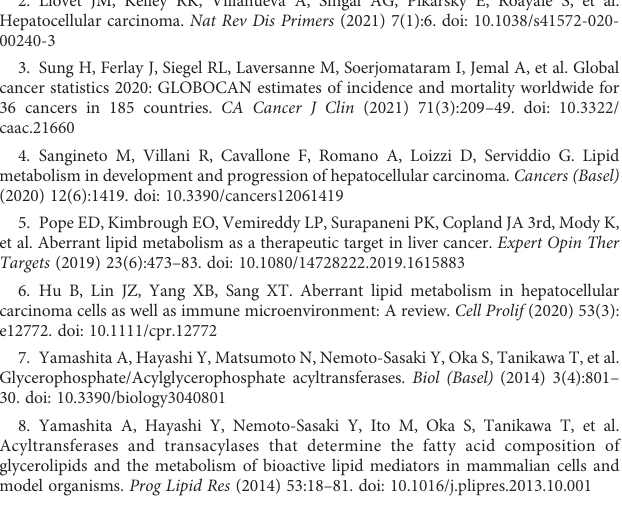
SUPPLEMENTARY FIGURE 1 Differential expression of GPAT / AGPAT gene family in patients with HCC (immunohistochemical staining data in the Human Protein Atlas [HPA] database). (A – I) The expression of GPAT3, AGPAT1, AGPAT2, AGPAT4, AGPAT5, LPCAT4, LCLAT1, LPCAT1, and LPCAT2 in tumor tissues and normal liver tissues (immunohistochemical staining data for AGPAT3 were not available in the HPA database). SUPPLEMENTARY FIGURE 2 Validation of the prediction model based on the GPAT / AGPAT gene family. (A) Correlation heat map of the seven genes signi fi cantly associated with overall survival. (B – D) Risk score distribution, risk grouping, survival outcome, and molecular expression for the prognostic model in the TCGA-LIHC validation set,TCGA-LIHCtotalset,andtheICGC-LIRIexternalvalidationset,respectively. (E, F) Univariate and multivariate Cox regression analysis identi fi ed risk score as an independent prognostic factor after the inclusion of clinical variables (ICGC- LIRI external validation dataset). SUPPLEMENTARY FIGURE 3 Validation of the ICGC-LIRI dataset for immune cell in fi ltration, Pan-cancer expression analysis. (A) Differences in immune cell in fi ltration between high- and low-risk groups within the ICGC-LIRI dataset. (B – D) The expression levels of AGPAT5 , LCLAT1 , and LPCAT1 in normal and pan-cancer tissues. SUPPLEMENTARY FIGURE 4 Quanti fi cation for Western blotting. (A – C) Expression of AGPAT5, LCLAT1, and LPCAT1 in common hepatocellular carcinoma cell lines. (D – F) Quanti fi cation for Western blotting (for ). Data are shown as the mean ± SD of at least three independent experiments. statistical analysis was performed using unpaired t- test to compare experimental and control groups. *P< 0.05, **P< 0.01, ***P<